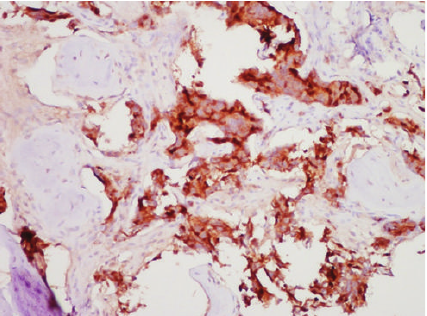
Figure 3: Left petrous bone biopsy, immunohistochemistry staining positive for pan keratin.